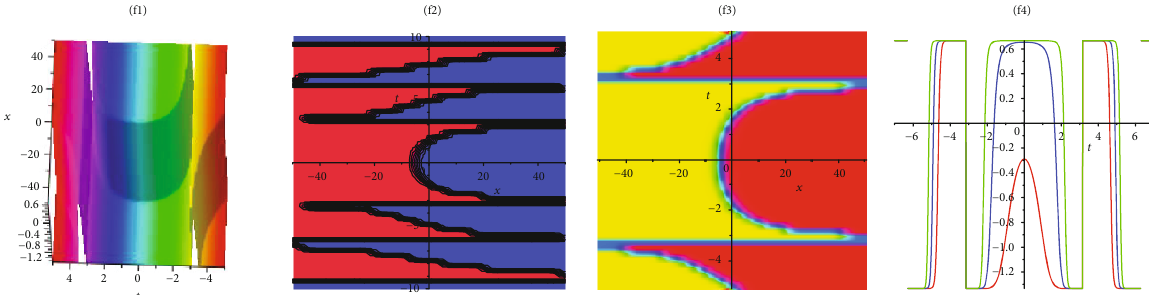
Figure 13: The one-wave solution (62) at α = 0 : 5, β = 0 : 2, α